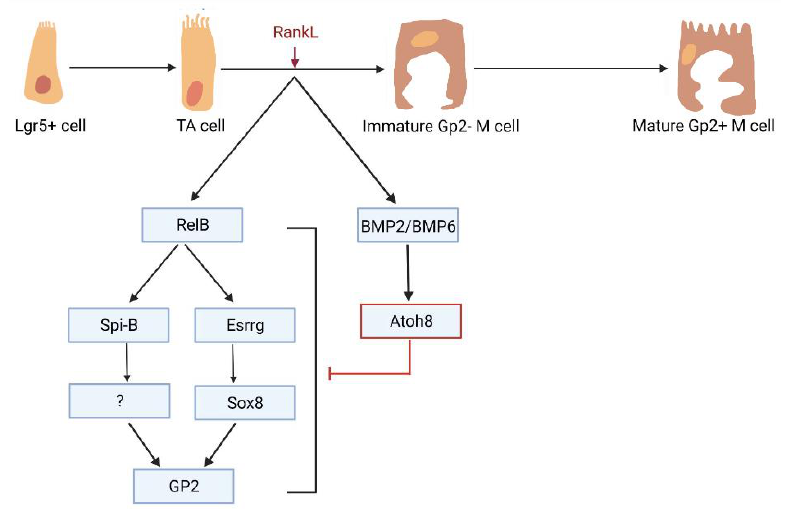
Figure 6. Atoh8 regulates the density of M cell population in the FAE. Loss of Atoh8 significantly increased the expression of M cell-associated transcription factors such as Spi-B, Sox8, Esrrg as well as early M cell expression markers. The population of Gp2+ M cells increased significantly in Atoh8 null mice.